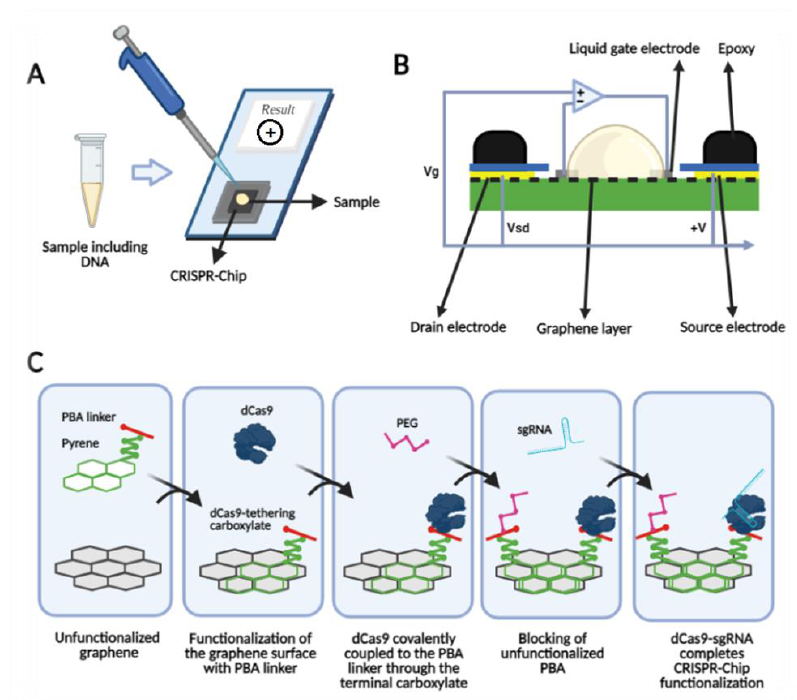
Figure 3. The schematic view of CRISPR–Chip functionalized with CRISPR–dCas9. ( A ) the CRISPR–Chip reports the results in 15 min; ( B ) the process of functionalization of the graphene surface; and ( C ) the components of the CRISPR–Chip including a liquid gate directly in contact with the sample, and three terminal gFETs utilizing functionalized graphene between source and drain electrodes.